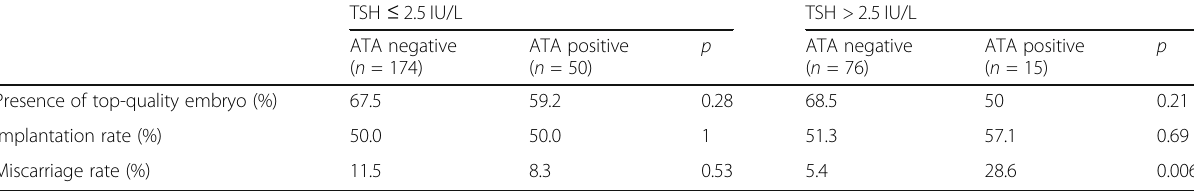
Table 3 Pregnancy outcome between negative and positive ATA for subgroup of TSH levels